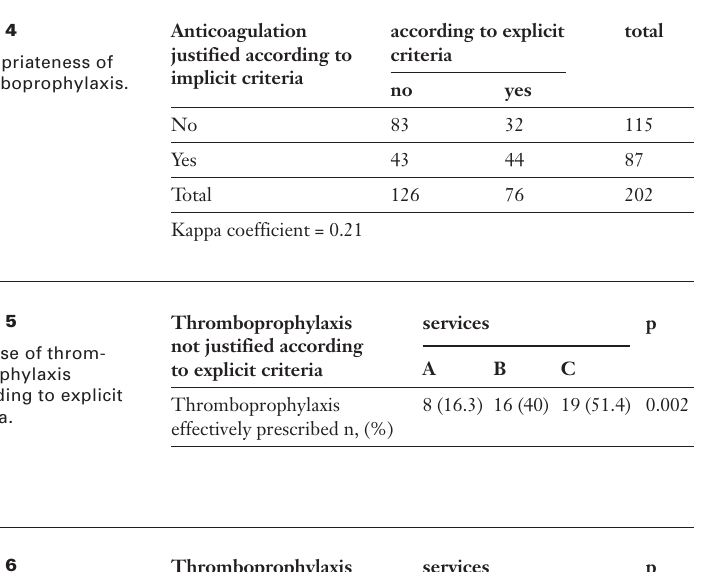
Underuse of throm- boprophylaxis according to explicit